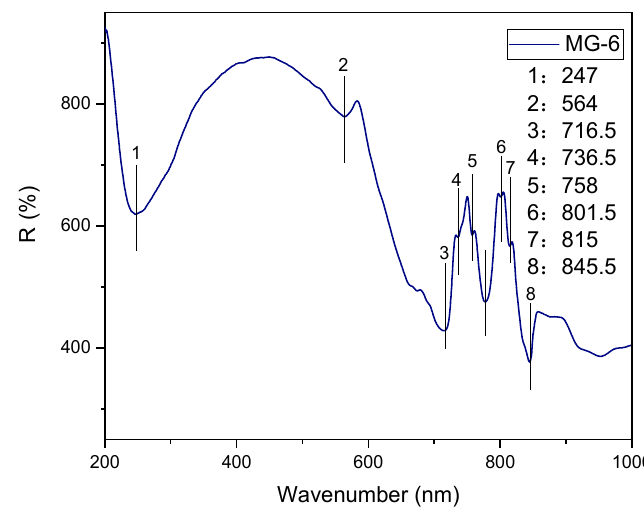
Figure 5. UV–Vis spectrum of MG-6.